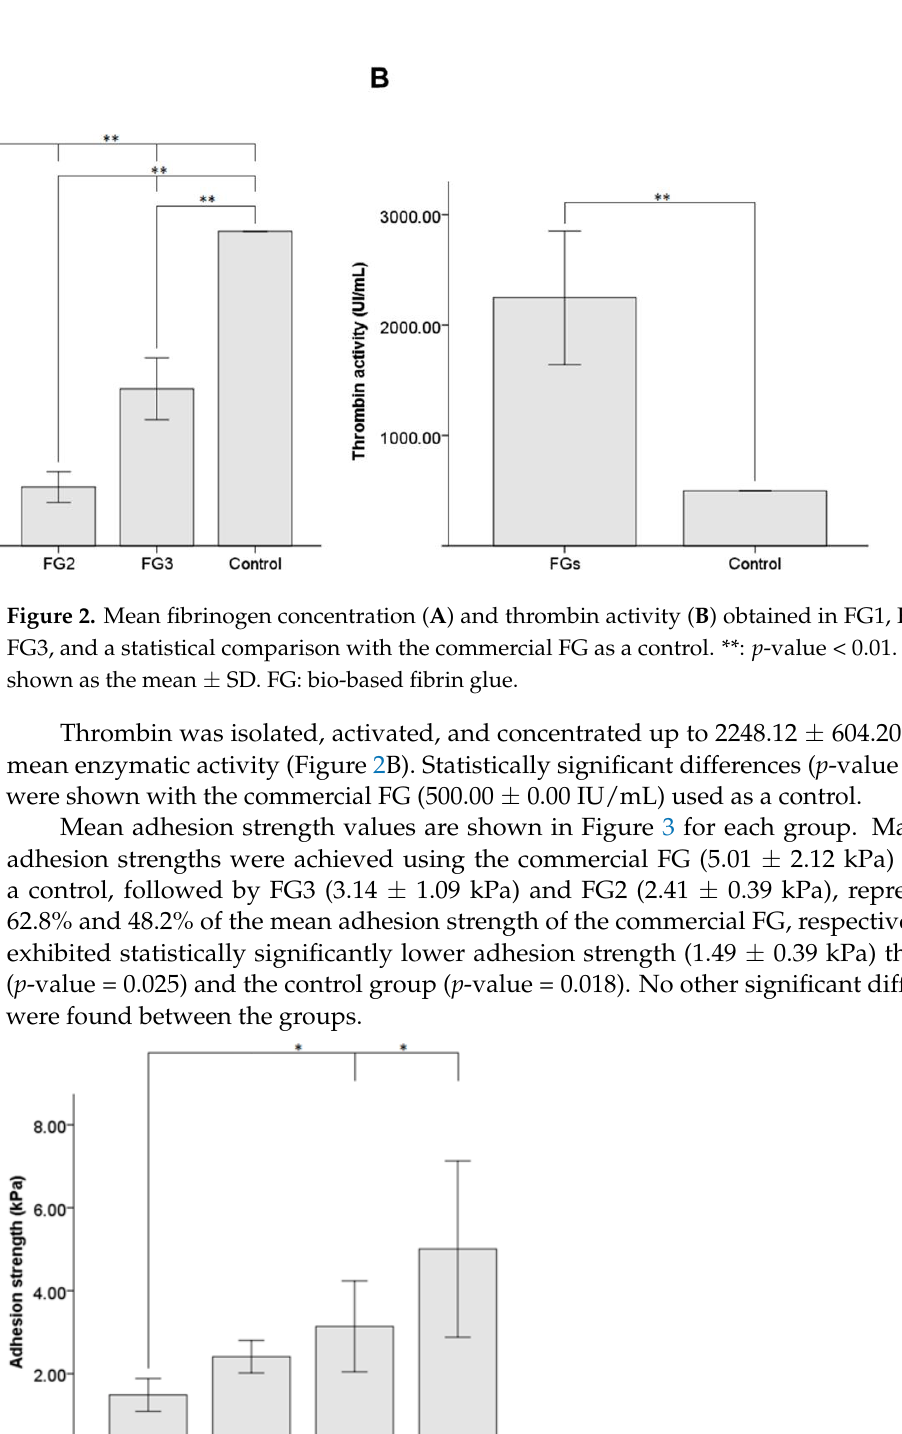
Figure 3. Mean adhesion strength obtained in FG1, FG2, and FG3 and a statistical comparison with the commercial FG as a control. *: p -value < 0.05. Data are shown as the mean ± SD. FG: bio-based fibrin glue.